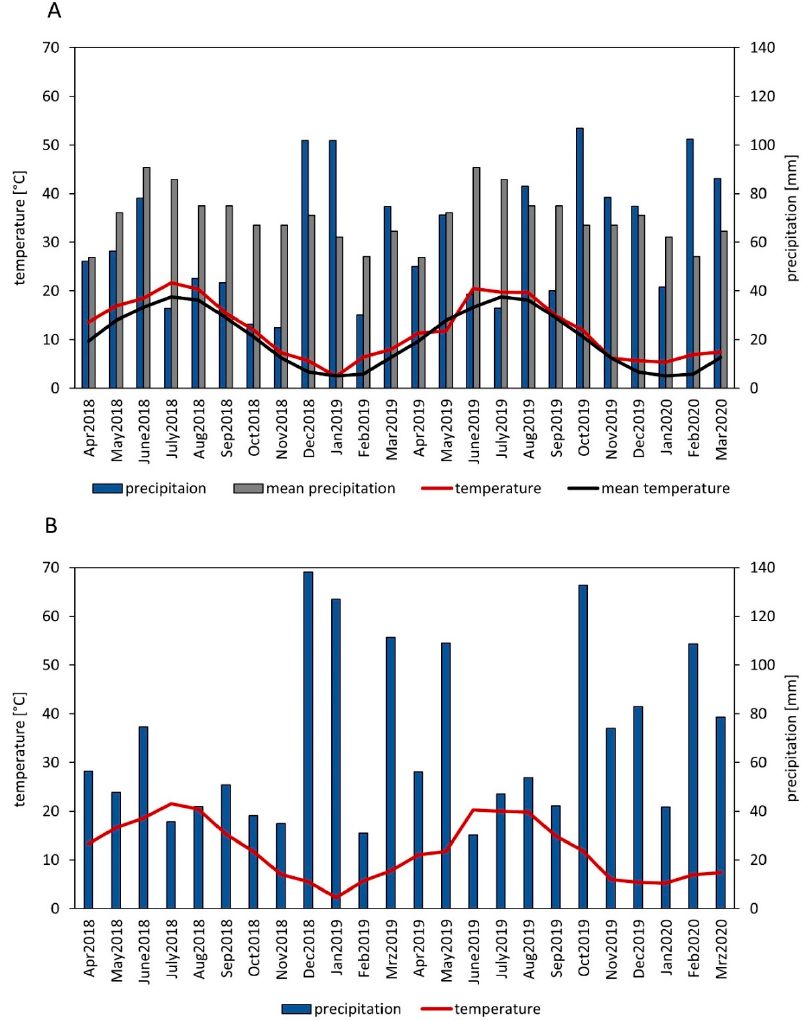
Figure 1. Precipitation [mm] and temperature [ ◦ C] of the experimental years compared to the long-term mean (1981–2010) at the nearby (12 km) weather station from the German Meteorological Service at Cologne Bonn Airport ( A ), Precipitation [mm] and temperature [ ◦ C] of the experimental years at the experimental station Wiesengut ( B ).